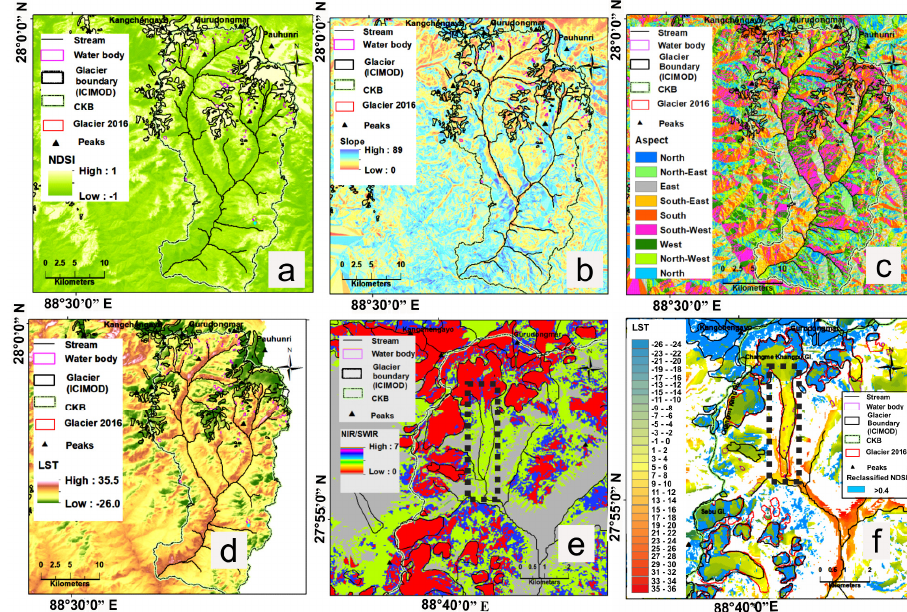
Figure 3. Parameters used for glacier boundary delineation: ( a ) NDSI map, ( b ) slope map (in °), ( c ) aspect map, ( d ) land surface temperature map (in °C), ( e ) NIR/SWIR map, ( f ) Composite map of LST, the glacier boundary modified from the International Centre for Integrated Mountain Development (ICIMOD) (2011) draped on ( a – e ) map, the ( f ) map contains the ICIMOD (2011) and 2016 glacier boundary. The dashed rectangular boxes in ( e ) and ( f ) map highlights the debris covered boundary of CK glacier.